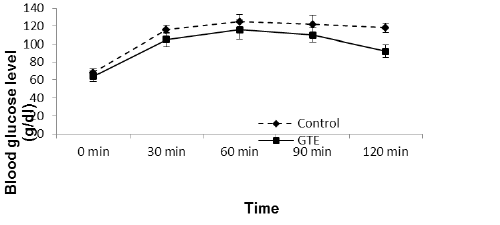
Figure 2. Oral glucose tolerance test of green tea extract (GTE) and control on Fructose-Fed Rats.